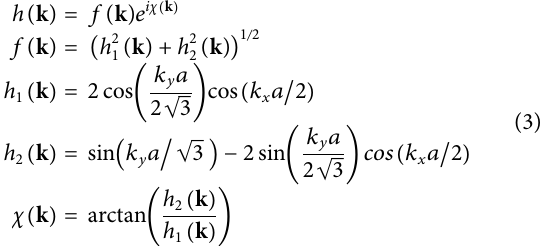
black) interpenetrating triangular Bravais sub-lattices. A unit cell